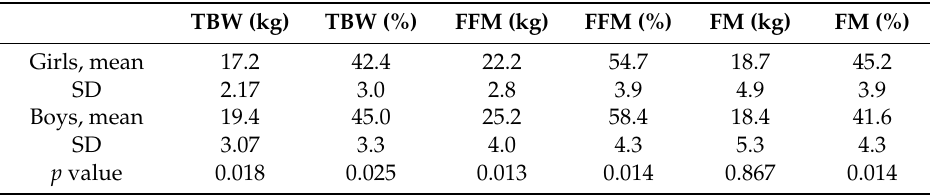
Table 1. Mean values and standard deviation (SD) for body composition parameters. Total body water (TBW), fat-free mass (FFM), and fat mass (FM) are expressed as kilograms (kg) and percent of total body weight (%). Results are based on 17 boys and 18 girls. TBW (kg)